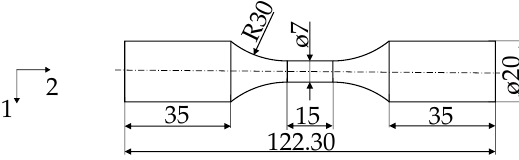
Figure 3. Geometry and dimensions (in mm) of the unnotched low cycle fatigue test specimens.